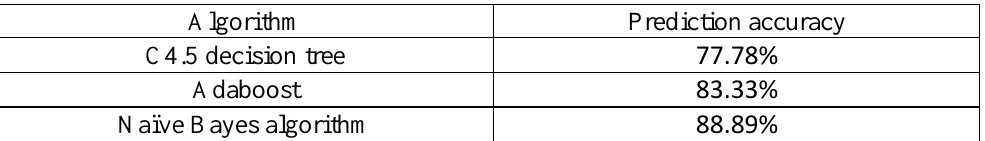
Table 8. Results of data mining